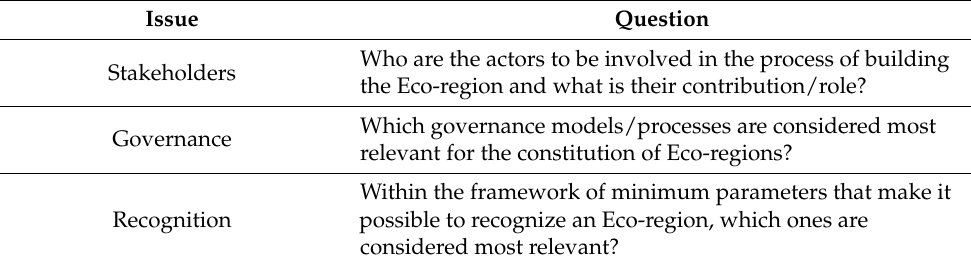
Table 4. Focus groups